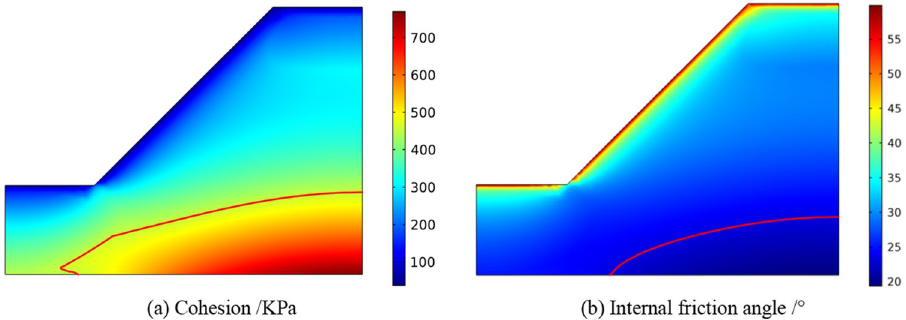
Figure 8. The distribution of cohesion and internal friction angle.